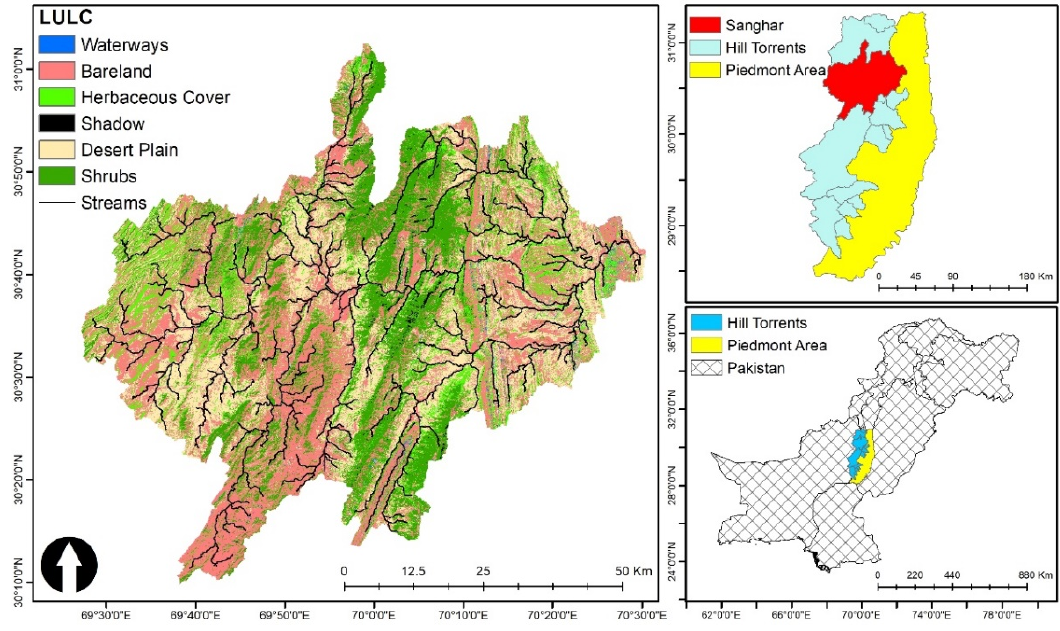
Figure 1. Geographical location of study area